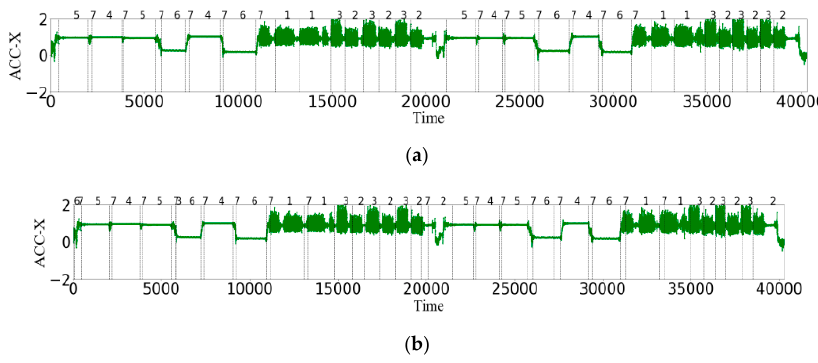
Figure 12. The actual label of the 22nd person ( a ), and the simulated online prediction of the 22nd person ( b ). The label of walking (WK) is “1”, the label of walking upstairs (WU) is “2”, the label of walking downstairs (WD) is “3”, the label of standing (SD) is “4”, the label of sitting (ST) is “5”, the label of lying (LY) is “6”, and the label of PTs is “7”.